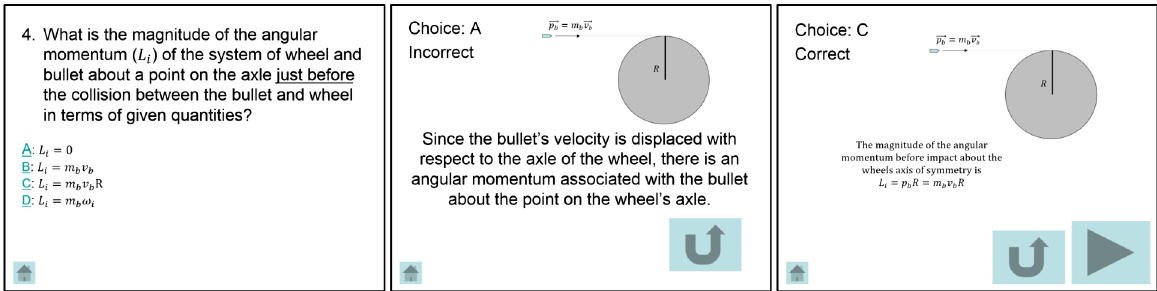
FIG. 3. Example of a subproblem from the tutorial focusing on conservation of angular momentum and adaptive support provided if the student provides an incorrect or a correct